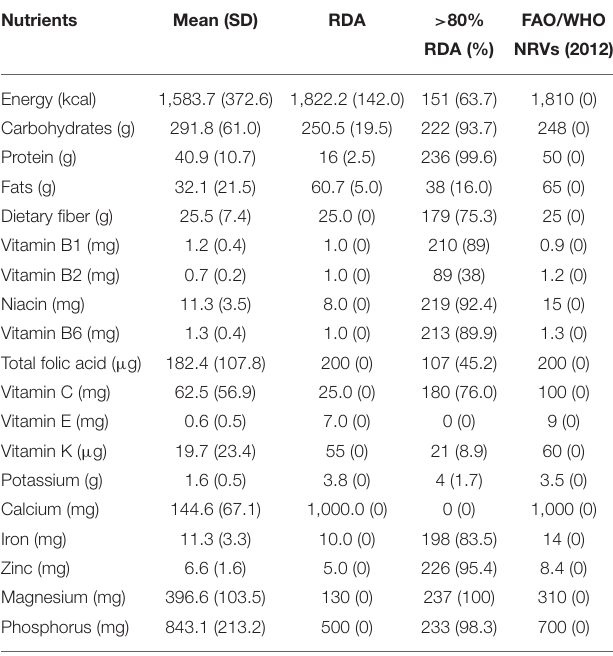
TABLE 1 | Mean (SD) daily energy and nutrient intake compared to RDAs among participating 5–7-year-old children ( N = 237) in Msambweni, Kenya. Nutrients